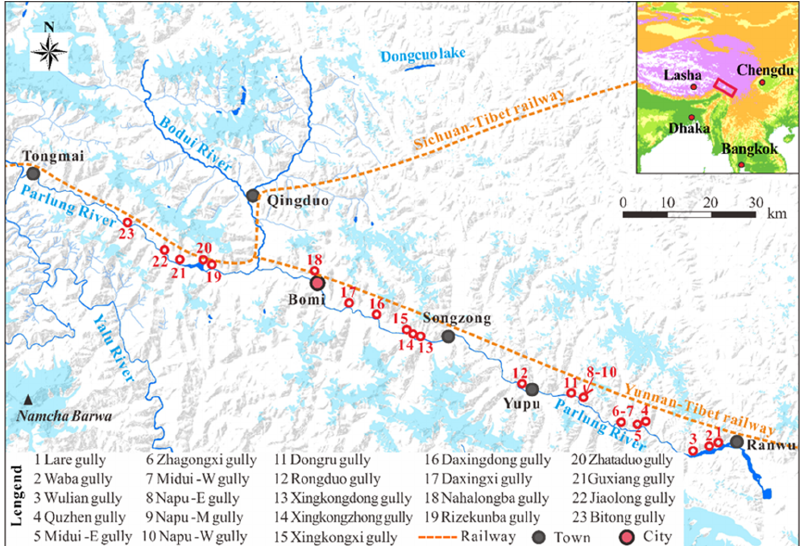
Figure 1. Sketch map of the investigated area.